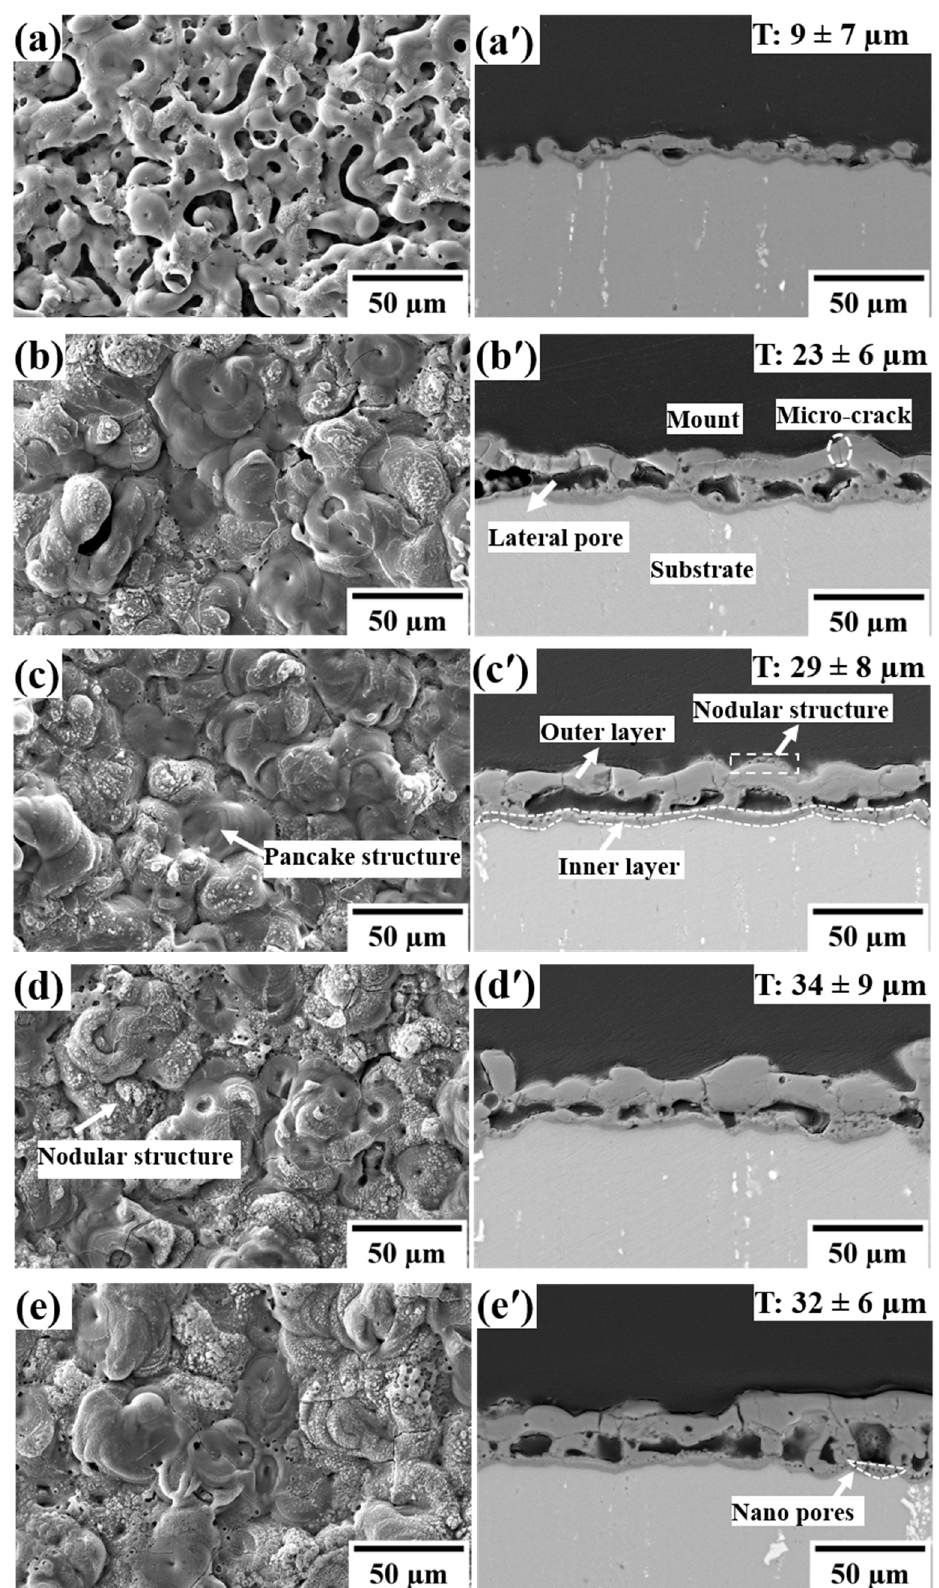
Figure 2. SEM images of surfaces and cross-sections of the PEO coated specimens: ( a , a ′ )-S0K2, ( b , b ′ )-S2K2, ( c , c ′ )-S3K2, ( d , d ′ )-S4K2, ( e , e ′ )-S5K2. Inserted values in the cross-section images are thickness, T.